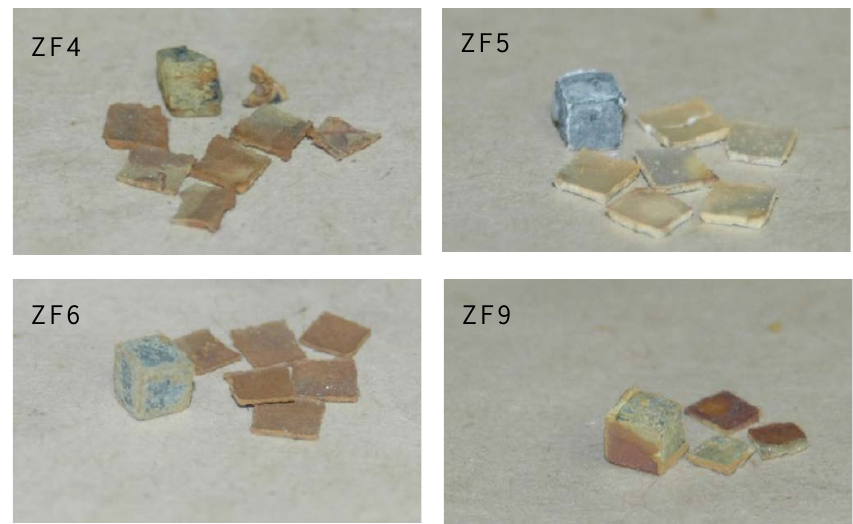
Figure 12. TG samples after isothermal oxidation at 1200 °C for 100 h showing the spallation of the scales.